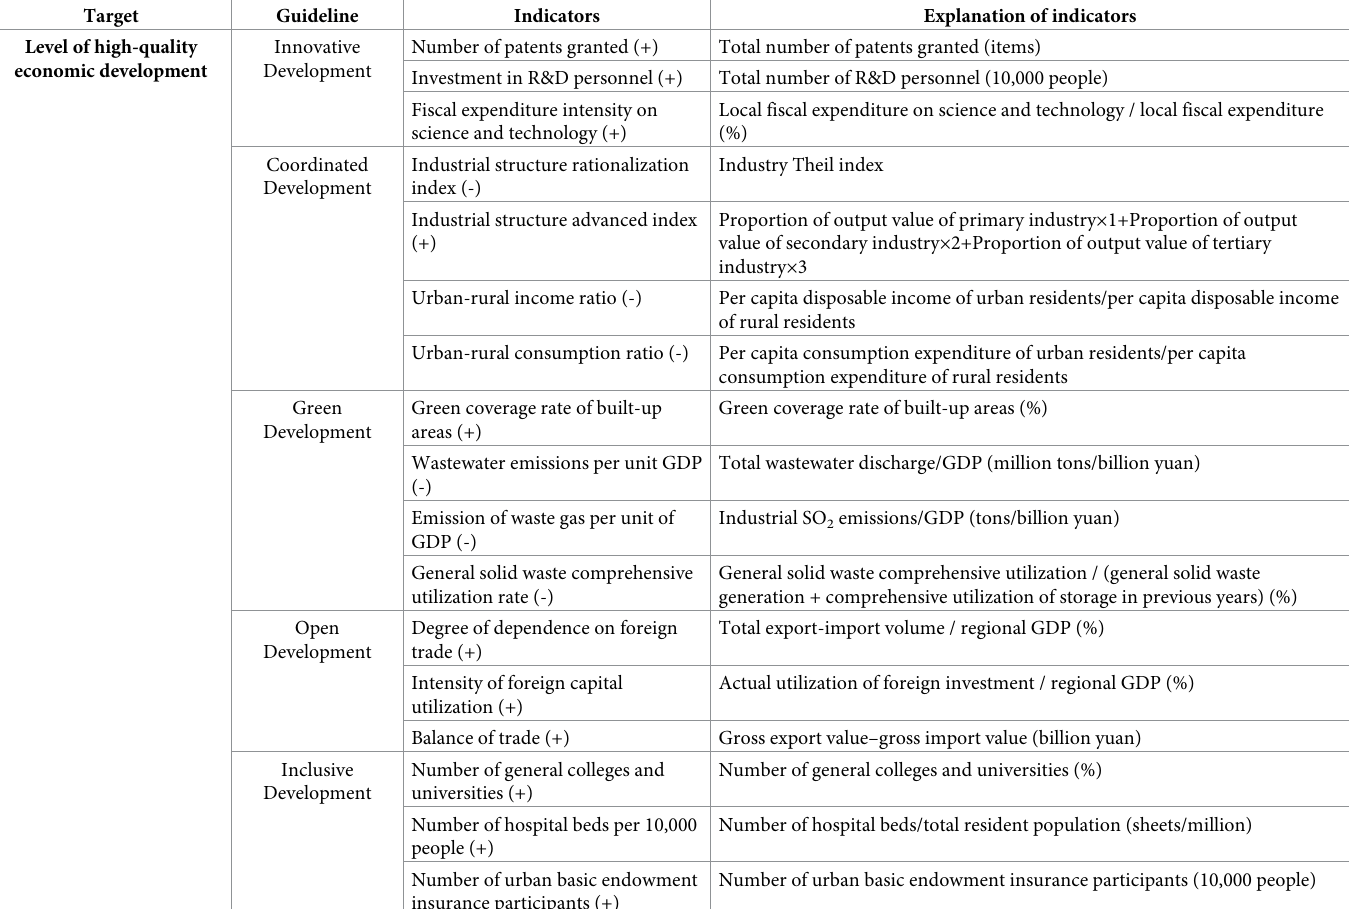
Table 4. Comprehensive evaluation index system of high-quality economic